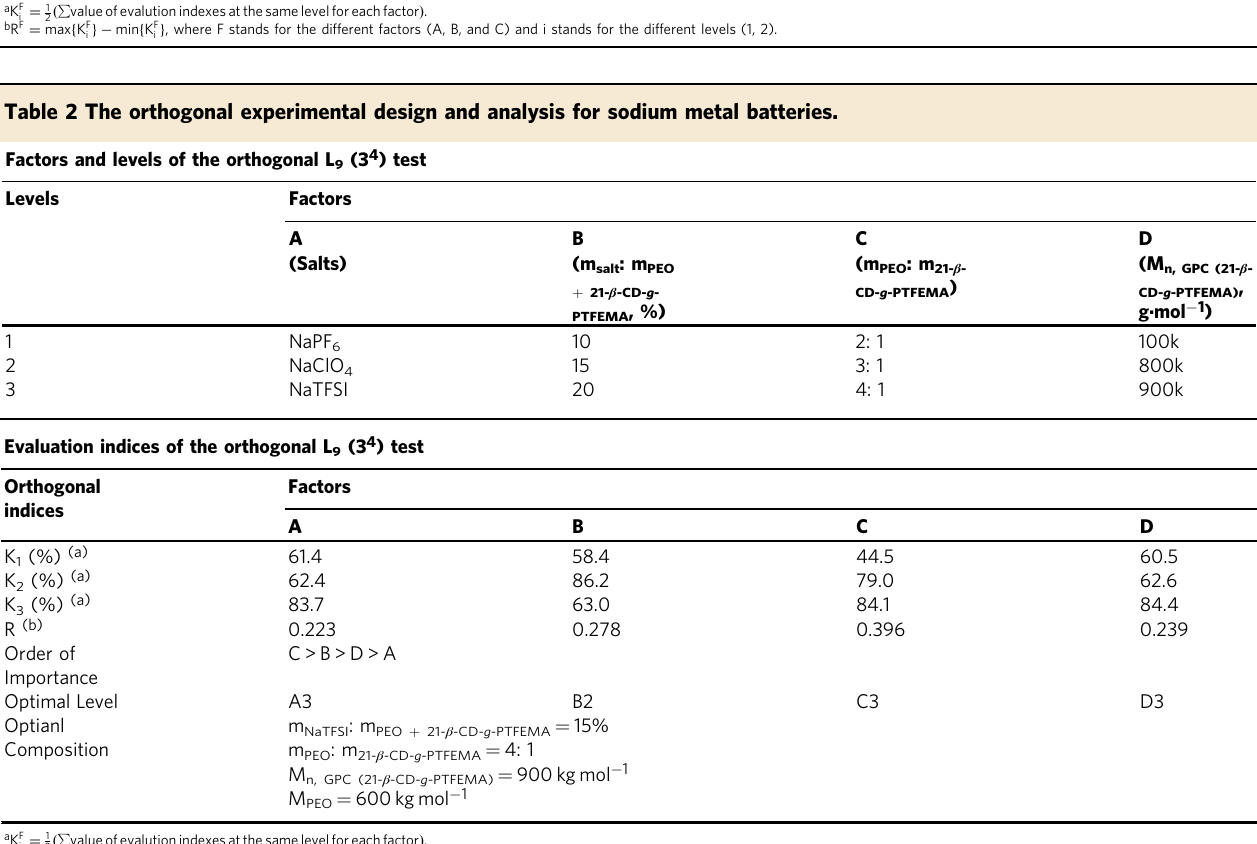
to the improvement in capacity retentions in high-voltage metal batteries 34 .